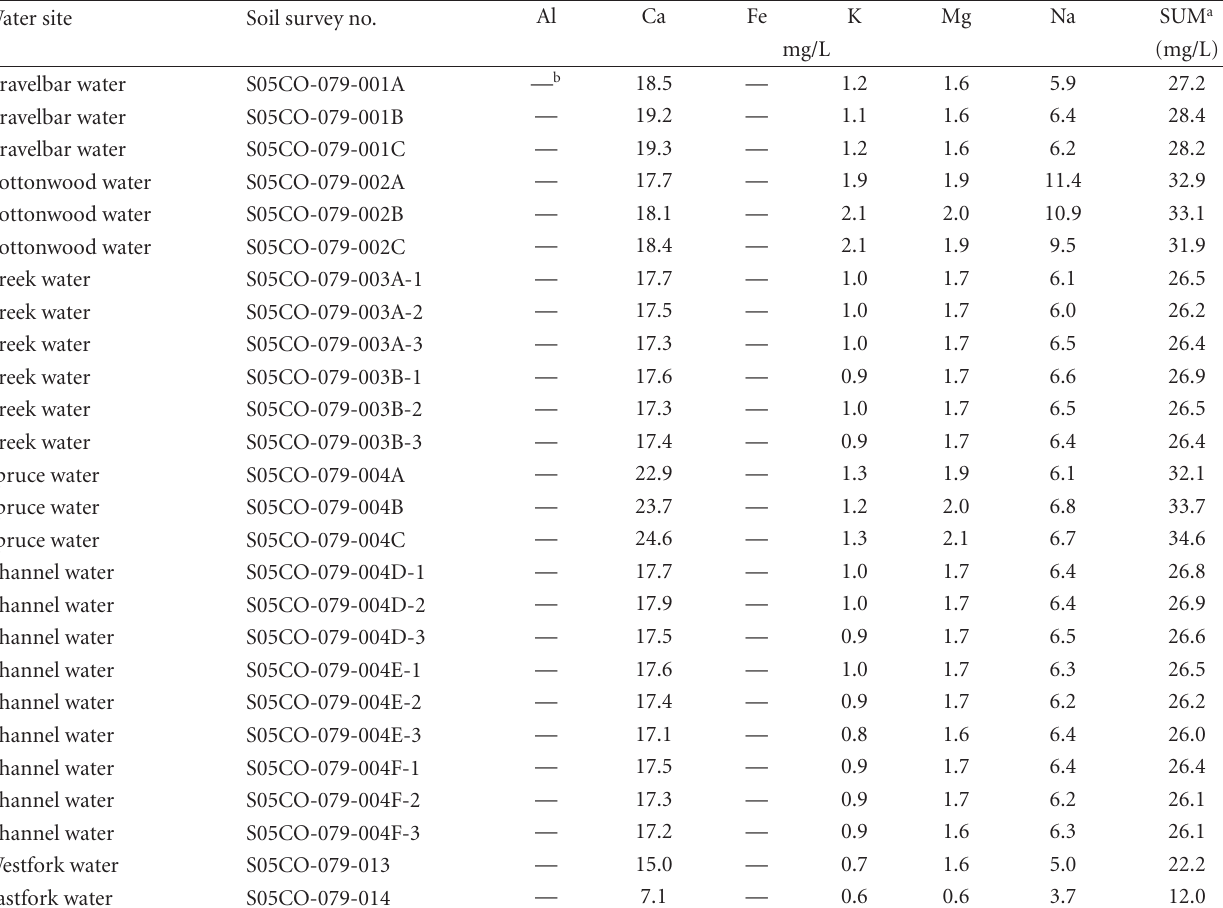
Table 4: Total major element concentrations for study